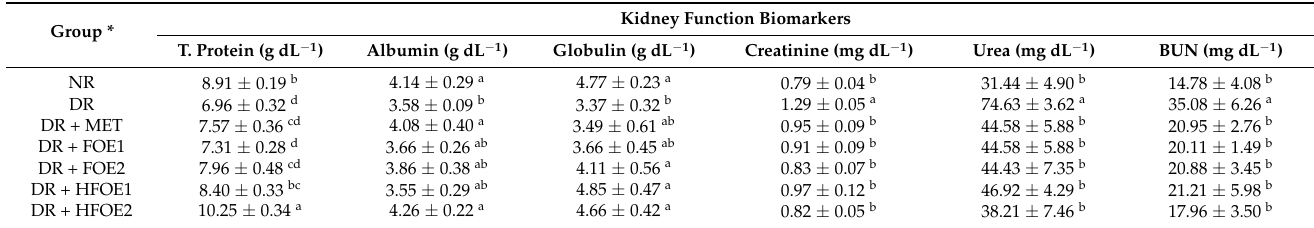
Table 7. Effect of orally administrated FOE and HFOE on kidney function biomarkers in STZ-induced diabetes in rats (mean ± SE), n = 8.